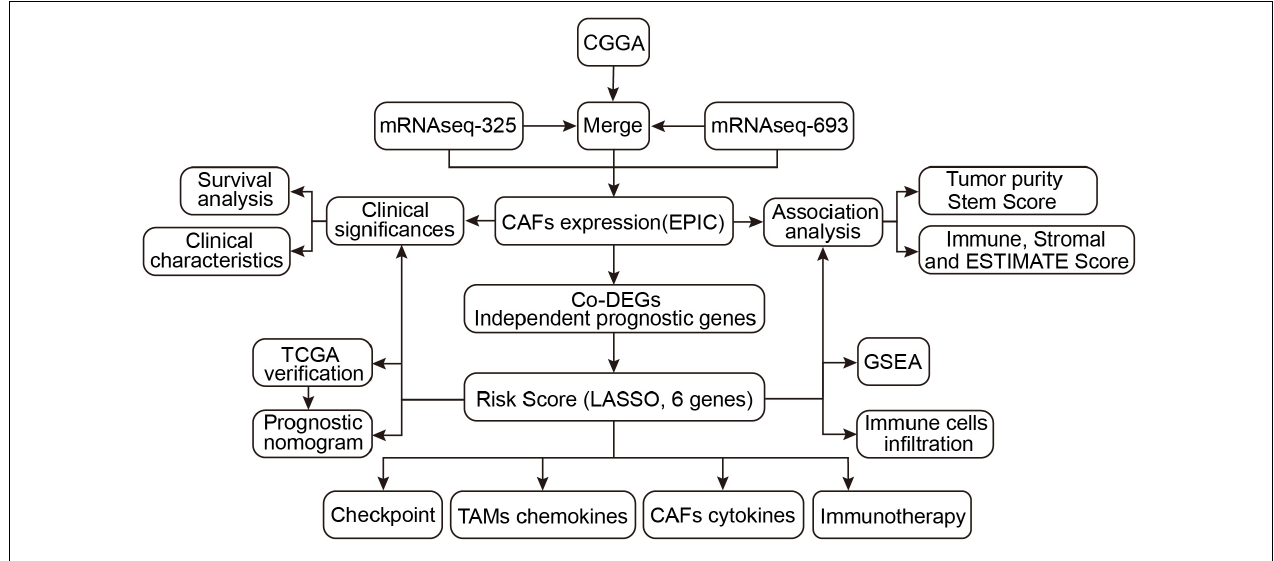
FIGURE 1 | Flowchart of the